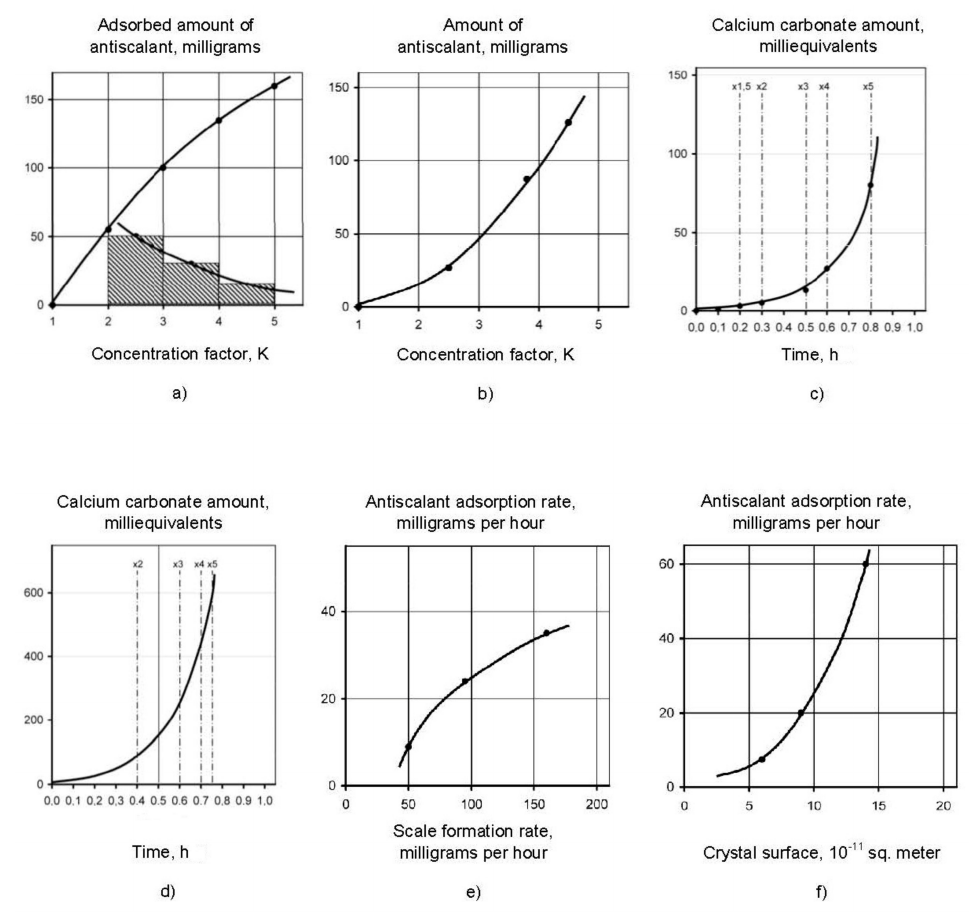
Figure 15. Steps to determine dependencies of: adsorption rate on K ( a ), amount of adsorbed antiscalant on K ( b ); amount of adsorbed antiscalant on time ( c ), antiscalant adsorption rate on time ( d ); antiscalant adsorption rate on crystal growth rate ( e ); antiscalant adsorption rate on crystal growth area ( f ).